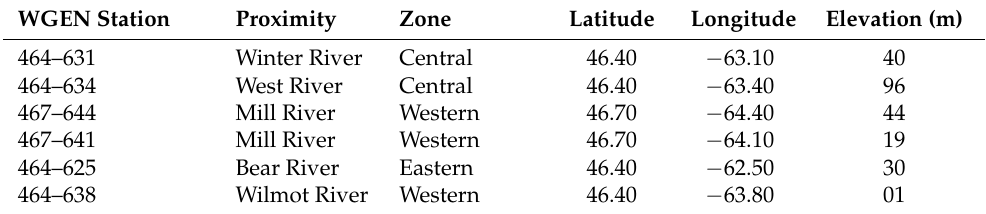
Table 2. WGEN stations used in modeling located in close proximity of the five